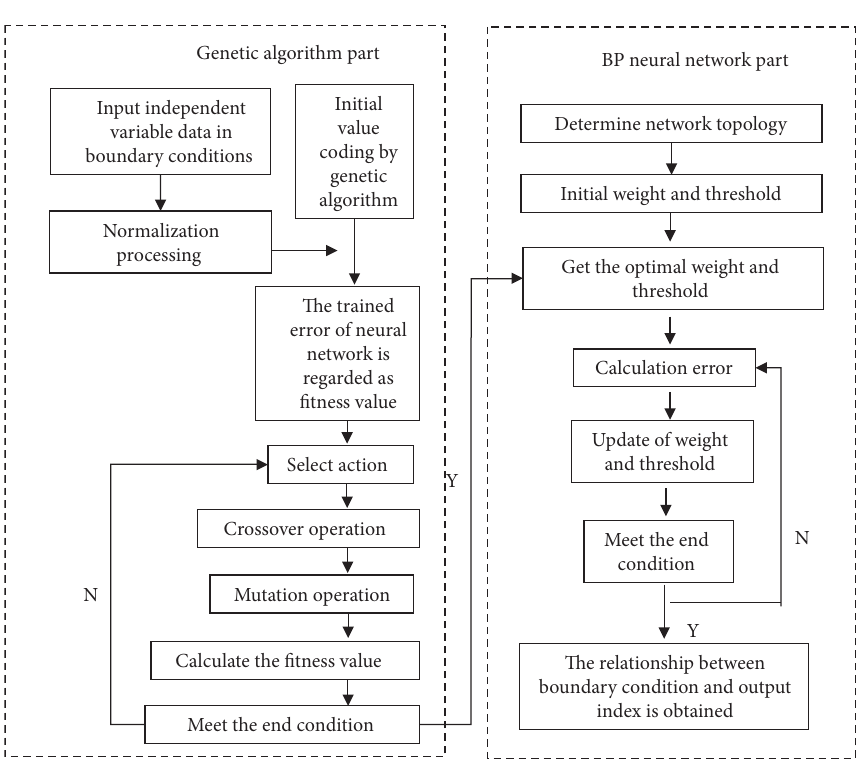
Figure 5: In situ stress inversion process.